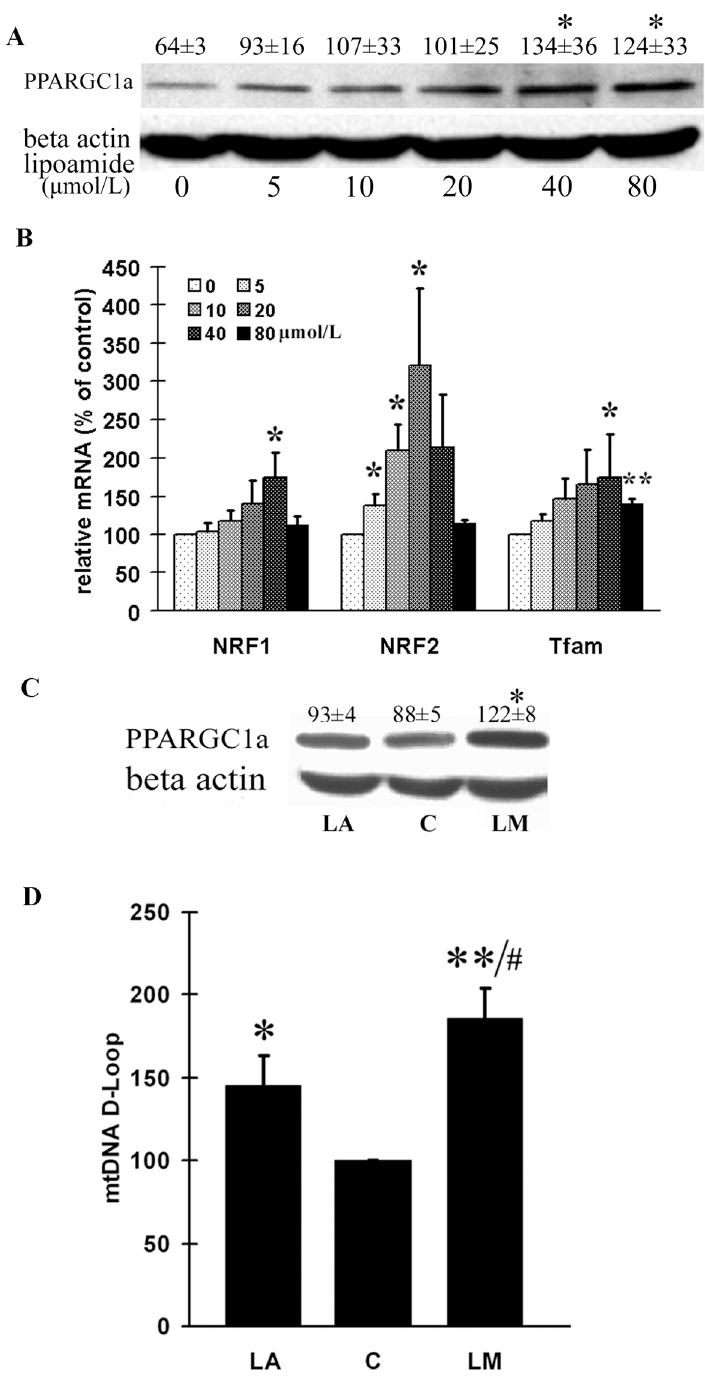
Fig 2. LM stimulated the expression of PPARGC1a, NRF-1, NRF-2 and Tfam, and LM was more potent than LA in inducing PPARGC1a expression and increasing mitochondrial DNA copy number. ARPE- 19 cells were treated with the indicated concentrations of LM for 48 h. (A) A representative image PPARGC1a expression in protein was examined by western blot. Optical densities of four independent images were analyzed with Quantity One software, and results were calculated as ratios of PPARGC1a to β - actin densities. (B) NRF-1, NRF-2 and Tfam mRNA expression levels were examined by real-time RT-PCR. The results were calculated as ratios of NRF-1, NRF-2 or TFAm to 18srRNA levels. Values are means ± SEM from four independent experiments. (C) A representative western blot of PPARGC1a expression from